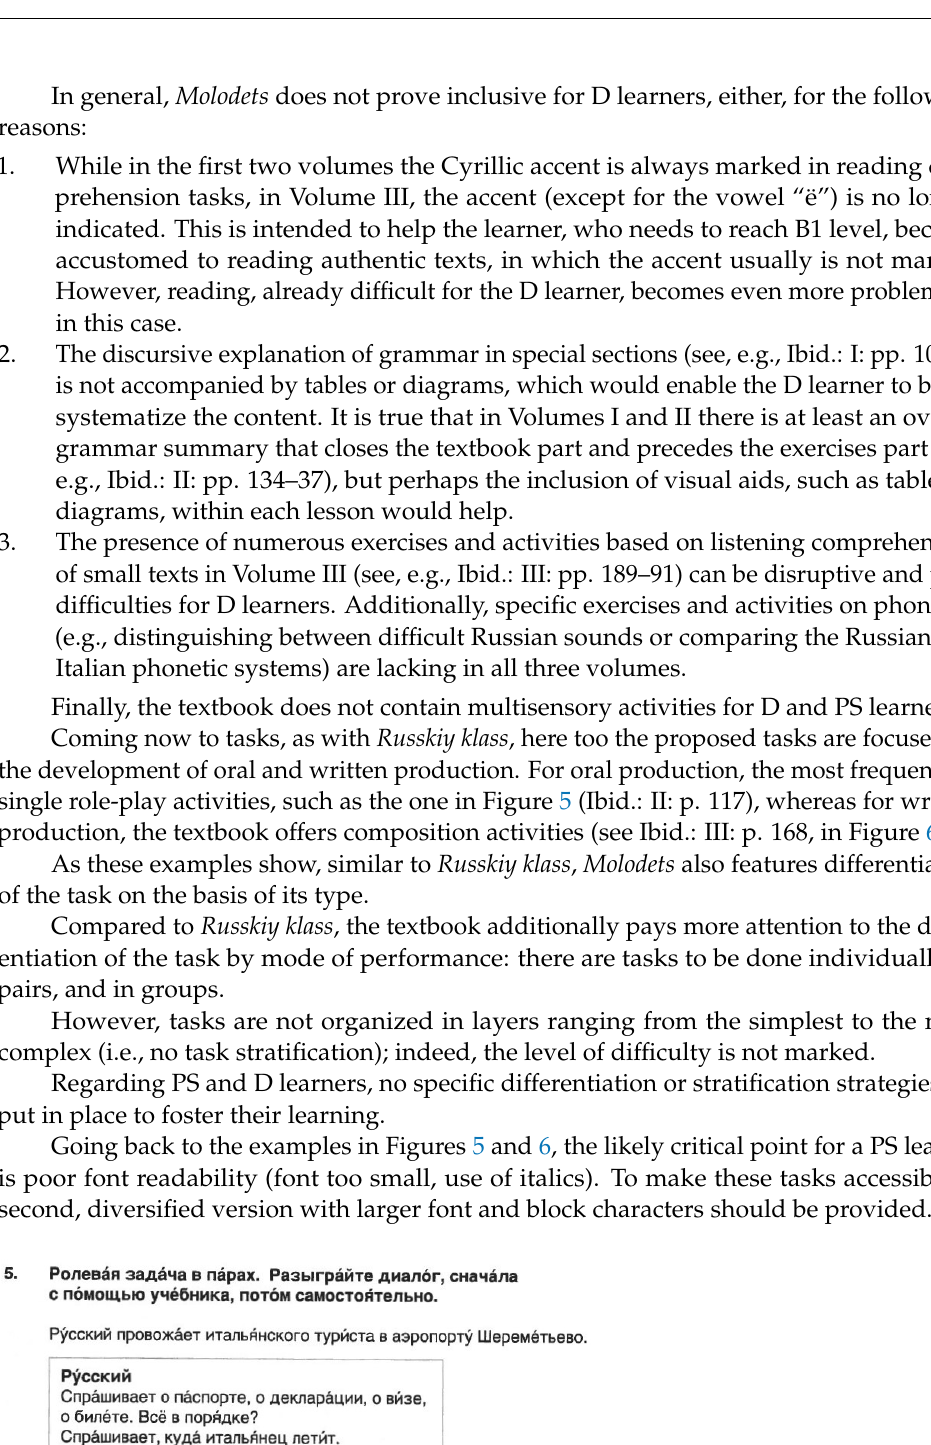
Figure 6. Example 2 of a task in Molodets . As these examples show, similar to Russkiy klass , Molodets also features differentiation of the task on the basis of its type. Compared to Russkiy klass , the textbook additionally pays more attention to the differentiation of the task by mode of performance: there are tasks to be done individually, in pairs, and in groups. However, tasks are not organized in layers ranging from the simplest to the most complex (i.e., no task stratification); indeed, the level of difficulty is not marked. Regarding PS and D learners, no specific differentiation or stratification strategies are put in place to foster their learning. Going back to the examples in Figures 5 and 6, the likely critical point for a PS learner is poor font readability (font too small, use of italics). To make these tasks accessible, a second, diversified version with larger font and block characters should be provided. Coming now to the D learner, the tasks present difficulty with regard to morphosyntactic, lexical, and argumentative aspects. One solution could be to implement task stratification (e.g., by adding Russian accents where they are missing, by proposing more guided and/or facilitated activities, or by dividing the tasks into stages) or a differentiation of time and mode of performance (e.g., by providing a second version of the tasks with more time allotted or giving the opportunity to do the written production in pairs).